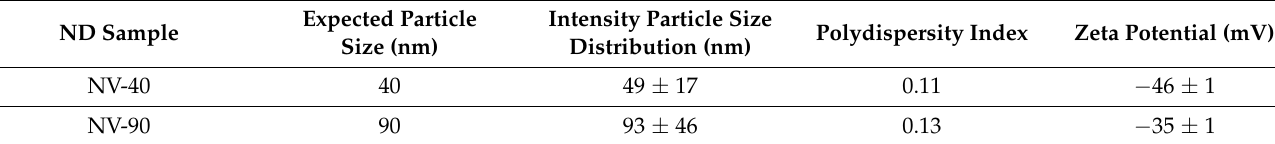
Table 1. DLS analysis of NV NDs.